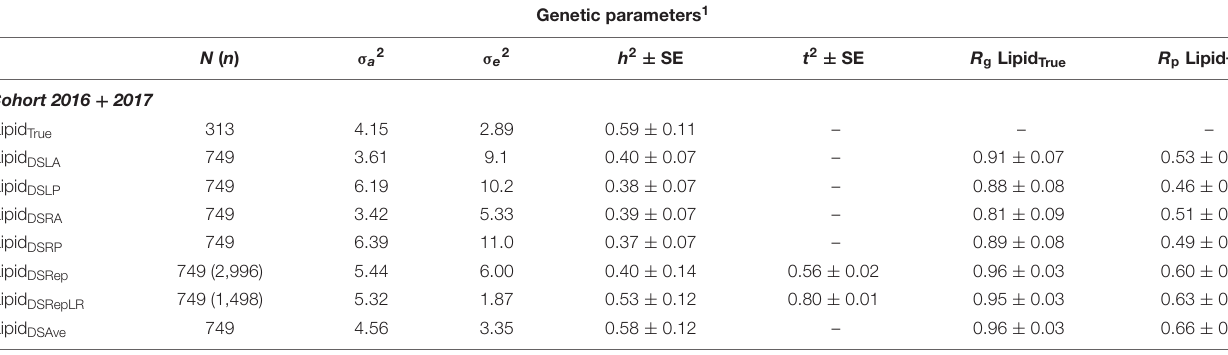
TABLE 2 | Genetic parameter between lipid content traits recorded on European seabass.